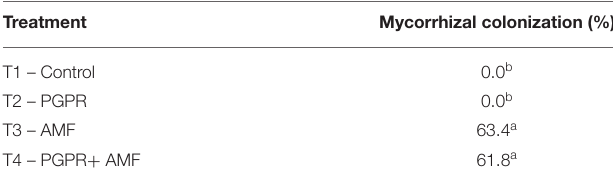
TABLE 3 | Percentage of mycorrhizal colonization of Tectona grandis seedling at 90 days. Treatment